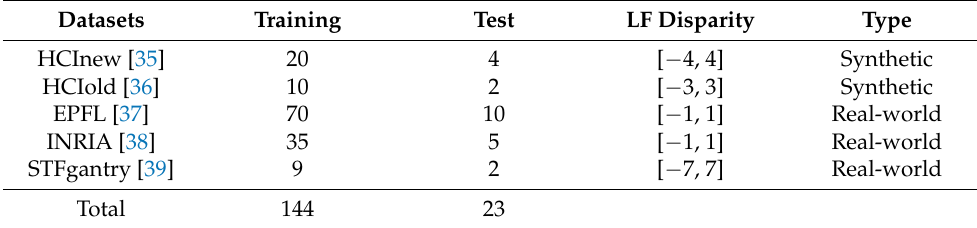
Table 1. Public LF datasets used in our